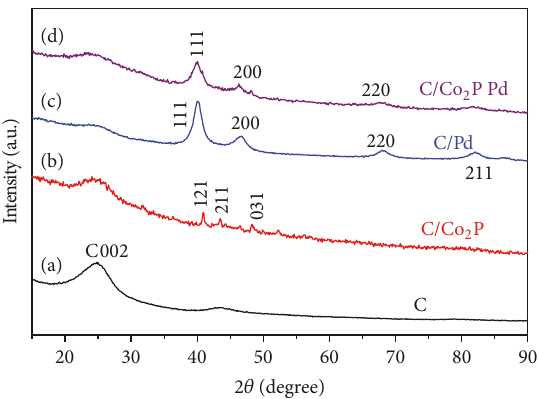
Figure 3: X-ray diffraction patterns for the Vulcan XC-72 carbon (a), C/Co 2 P composite (b), C/Pd composite (c), and the C/Co 2 P/Pd composite